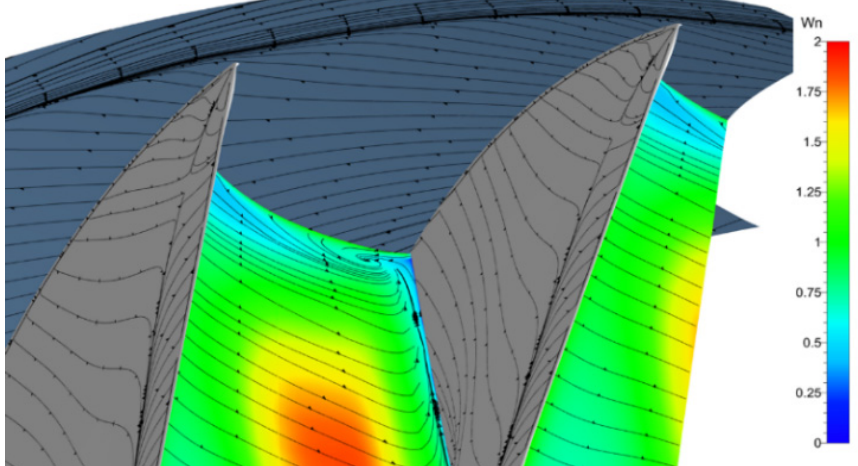
Figure 16. Streamline on suction side, casing, and passage outlet.